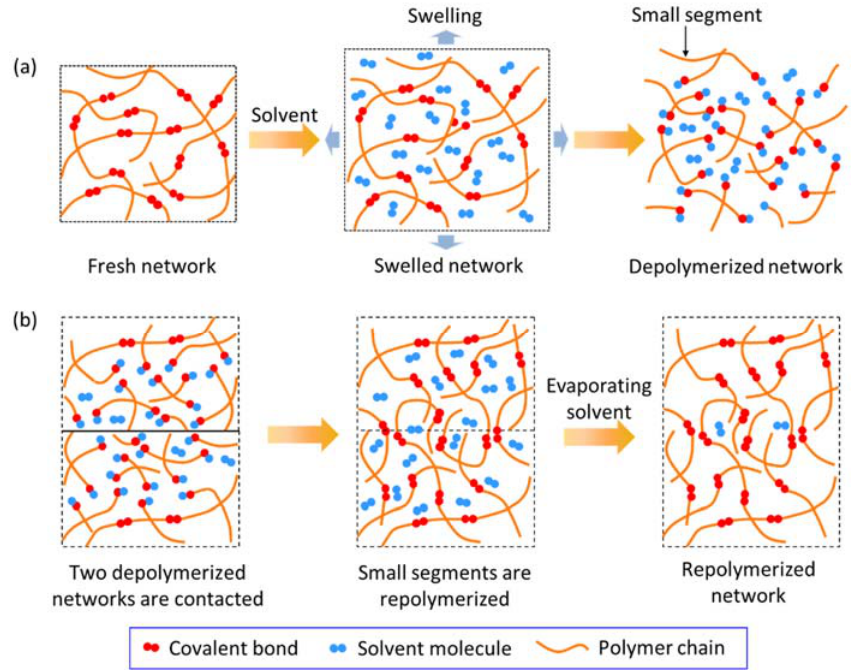
Figure 1. Schematic representation of depolymerizing and welding for vitrimer. ( a ) Original network is depolymerized into small segments. ( b ) Two depolymerized networks are repolymerized for welding.